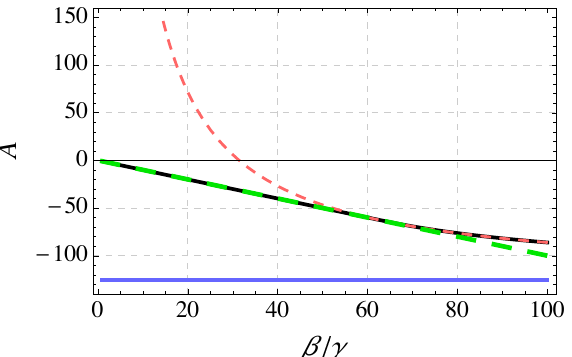
Figure 5. Plots of the coe(cid:14)cient A in the late time behavior of the two point function h O L O R i (cid:24) e At=(cid:12) as a function of (cid:12)=(cid:13) . The black curve describes A in our decohered state. The red dashed curve corresponds to the approximation given by (8.7): A = (cid:0) 4 (cid:25) (cid:1) O +4 (cid:25) 2 (cid:1) 2 green dashed curve corresponds to the approximation given by (8.8): A = (cid:0) (cid:12)=(cid:13) . In these plots, we set (cid:1) O = 10. The blue line shows the value of A for the TFD state